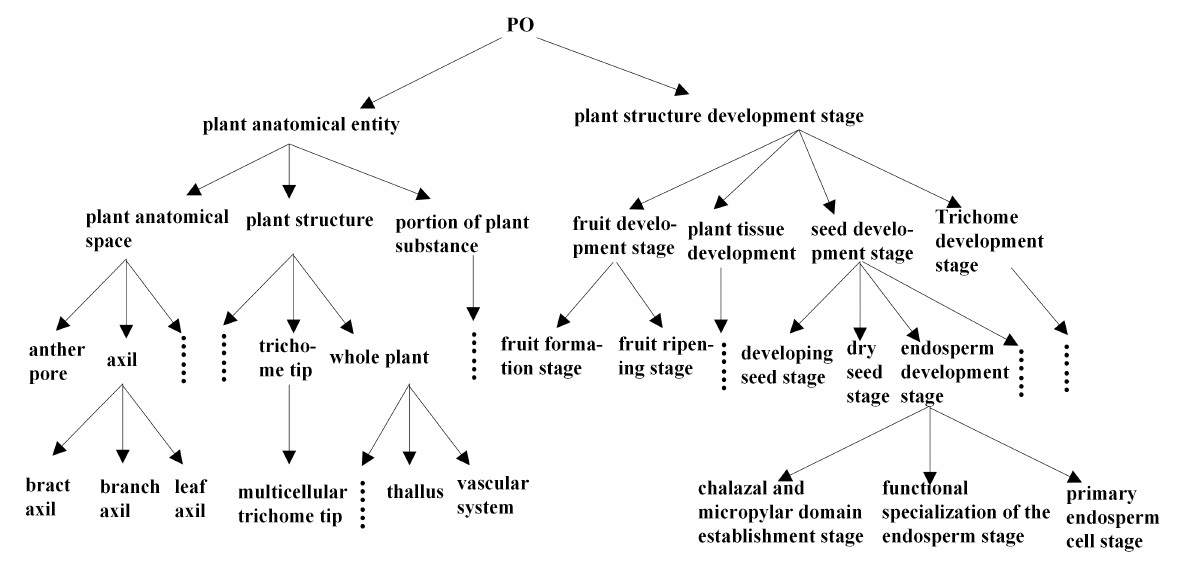
Fig. 4 The Structure of “PO” Ontology.